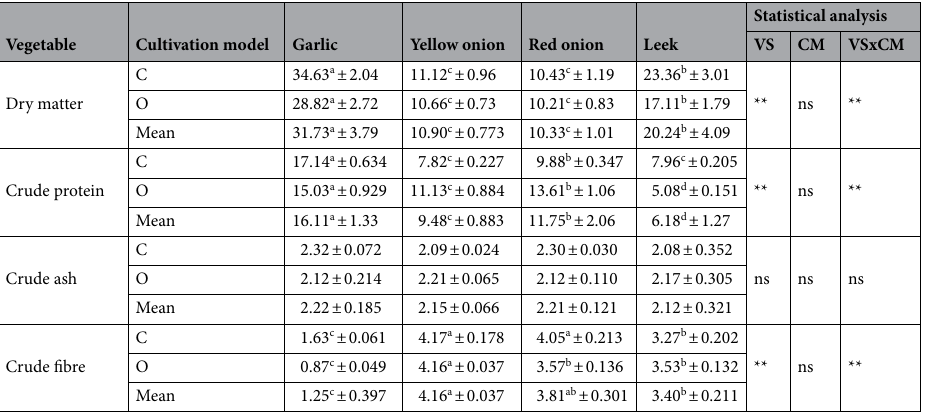
Table 1. Content of nutrients (g 100 g −1 ) in Allium vegetables depending on the cultivation model (conventional—C; organic—O). VS vegetable species, CM cultivation model (conventional vs. organic), ns no statistics. *Correlation significant at p ≤ 0.05 (one-way analysis). **Correlation significant at p ≤ 0.01 (one-way analysis). a,b ,c Values with different superscript letters in a row are significantly different at p ≤